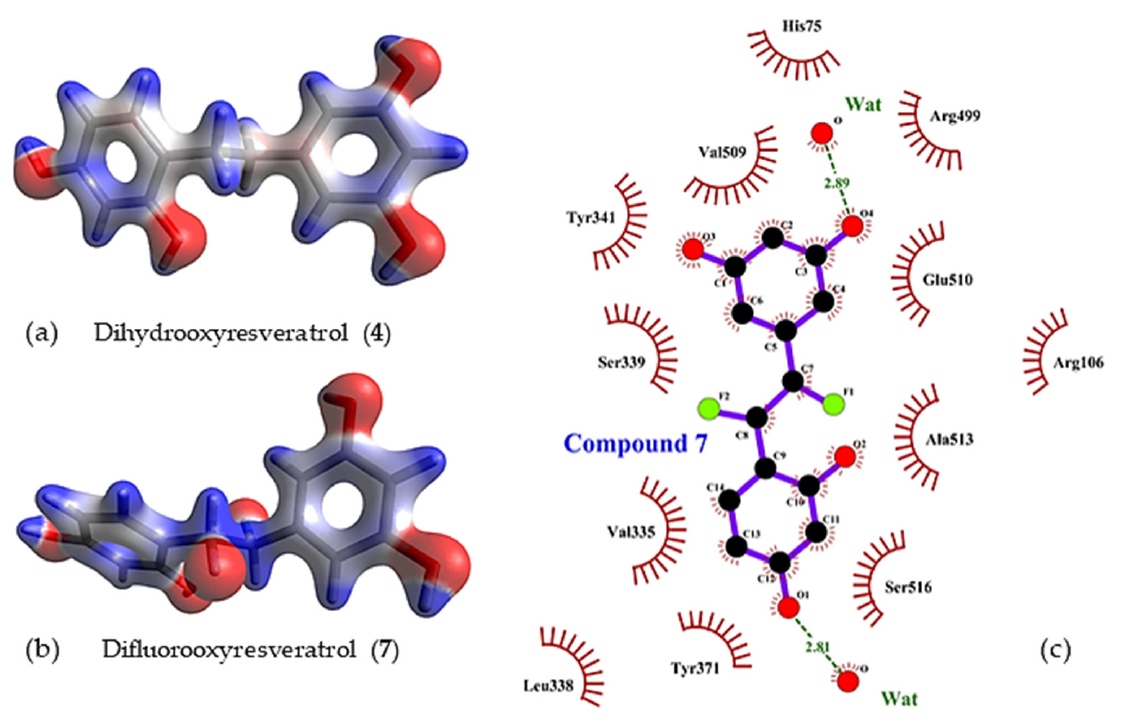
Figure 7. Electron density of ( a ) dihydrooxyresveratrol ( 4 ) and ( b ) difluorooxyresveratrol ( 7 ) in ( c ) 2D representation at a COX-2 pocket.